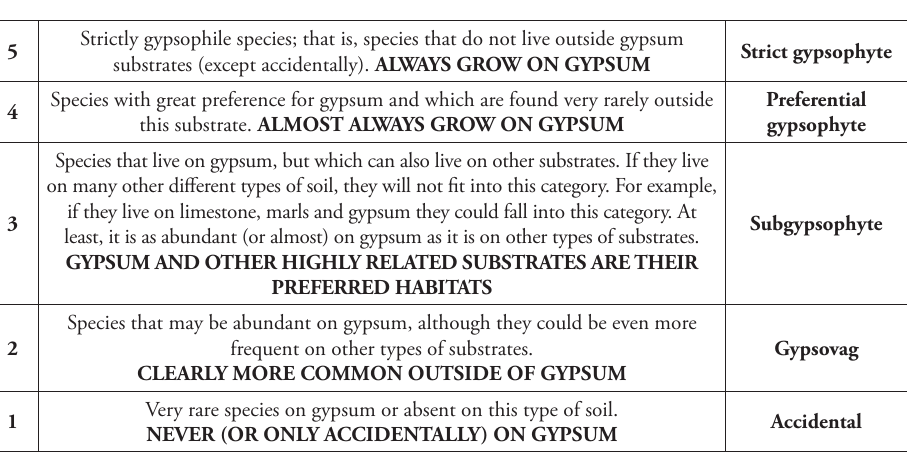
Table 1. Likert scale ranking for the gypsophilous character of the